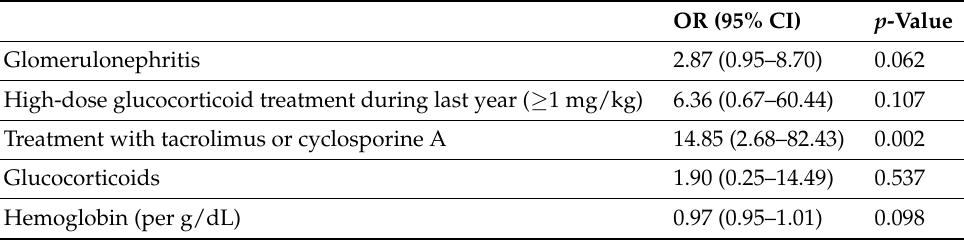
Table 4. Multivariate analysis of risk factors for non-response in HD patients. OR odds ratio, CI confidence interval.